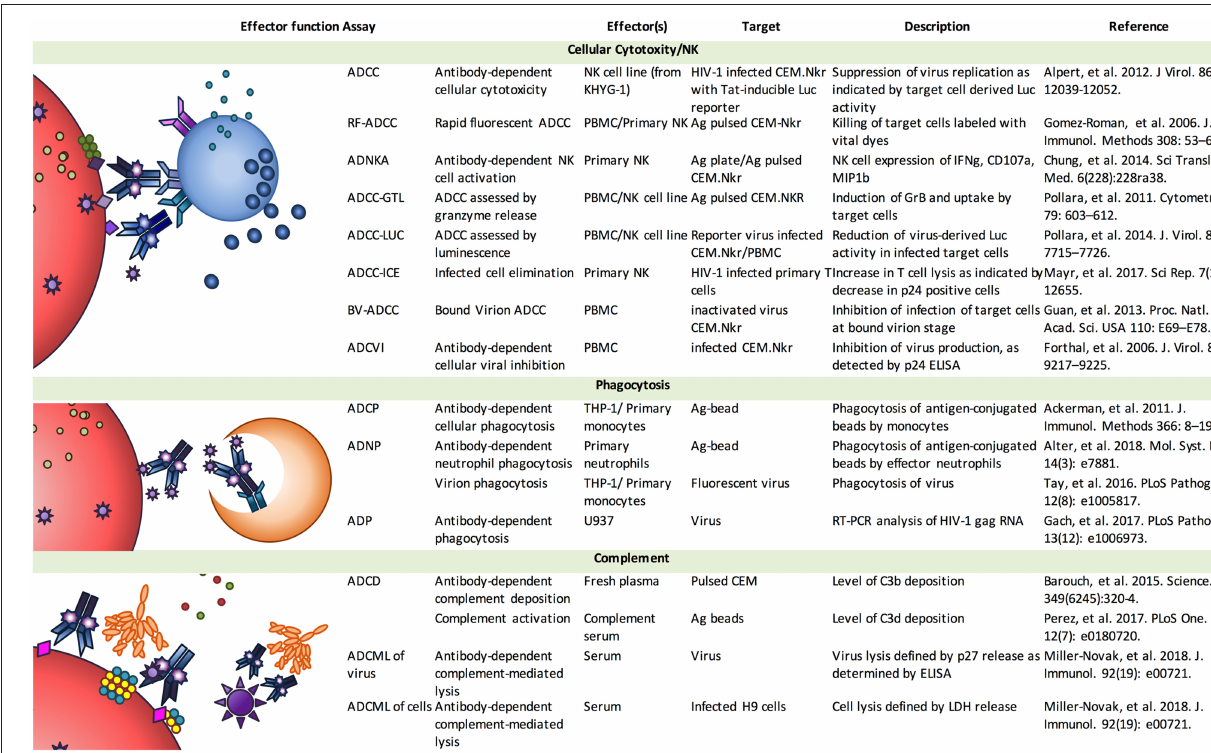
FIGURE 2 | Effector function assays. Antibodies elicit the activities of a diverse array of effector cell types and mechanisms, leading to the generation of a variety of in vitro assays aimed at characterizing the activity of mAb and pAb samples, and defining further insights into basic mechanisms. Image adapted from (7).